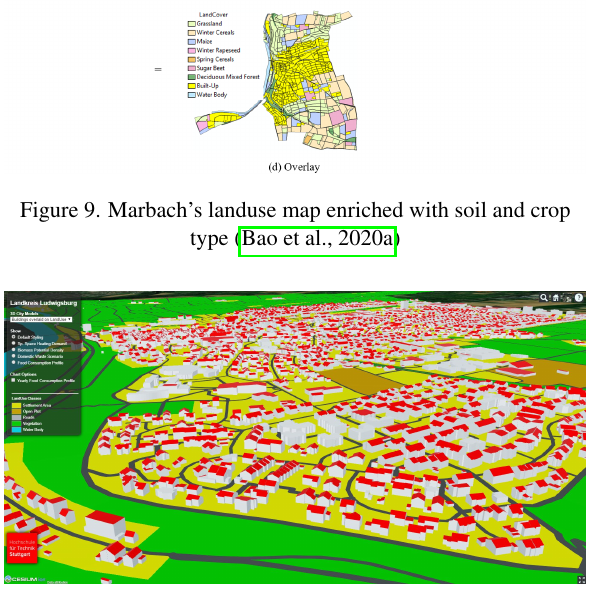
Figure 10. Marbach’s landuse data visualised with its building stock on web